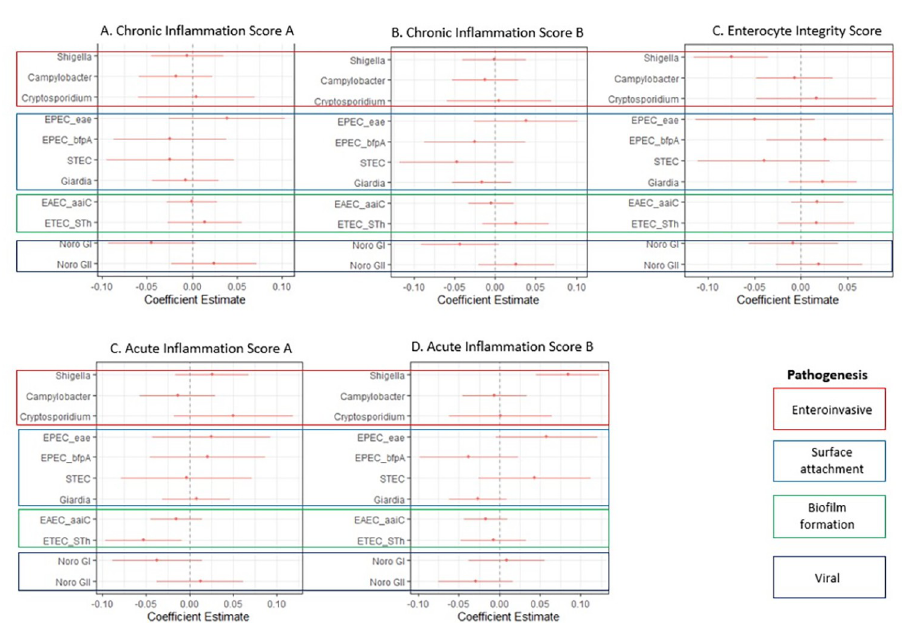
Fig 4. Associations between the data derived score and stool pathogen gene counts; (a) associations between Chronic Inflammation Score A (SI, AAT, and neopterin) and stool pathogen gene counts, (b) associations between Chronic Inflammation Score B (Cdx1, mucin12, and neopterin) and stool pathogen gene counts (c) associations between Enterocyte Integrity (SI, mucin12, and S100A8) and stool pathogen gene counts, (d) associations between stool pathogen gene counts and the Acute Inflammation Score A (Cdx1, S100A8, and MPO), and (e) associations between stool pathogen gene counts and Acute Inflammation Score B (Cdx1 and S100A8).